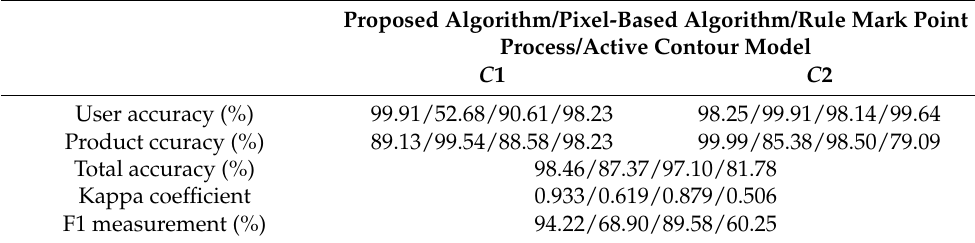
Table 2. Synthetic image quantitative evaluation. Proposed Algorithm/Pixel-Based Algorithm/Rule Mark